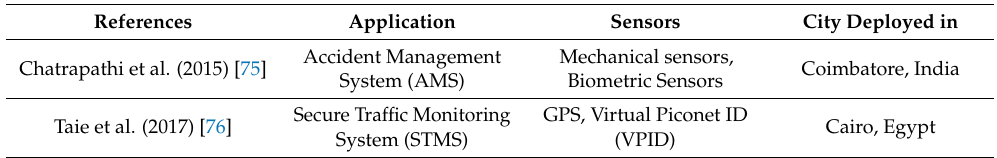
Table 10. Examples of prototyped applications for VANET.AMS: Accident Management System; STMS: Secure Traffic Monitoring System; VPID: Virtual Piconet ID.